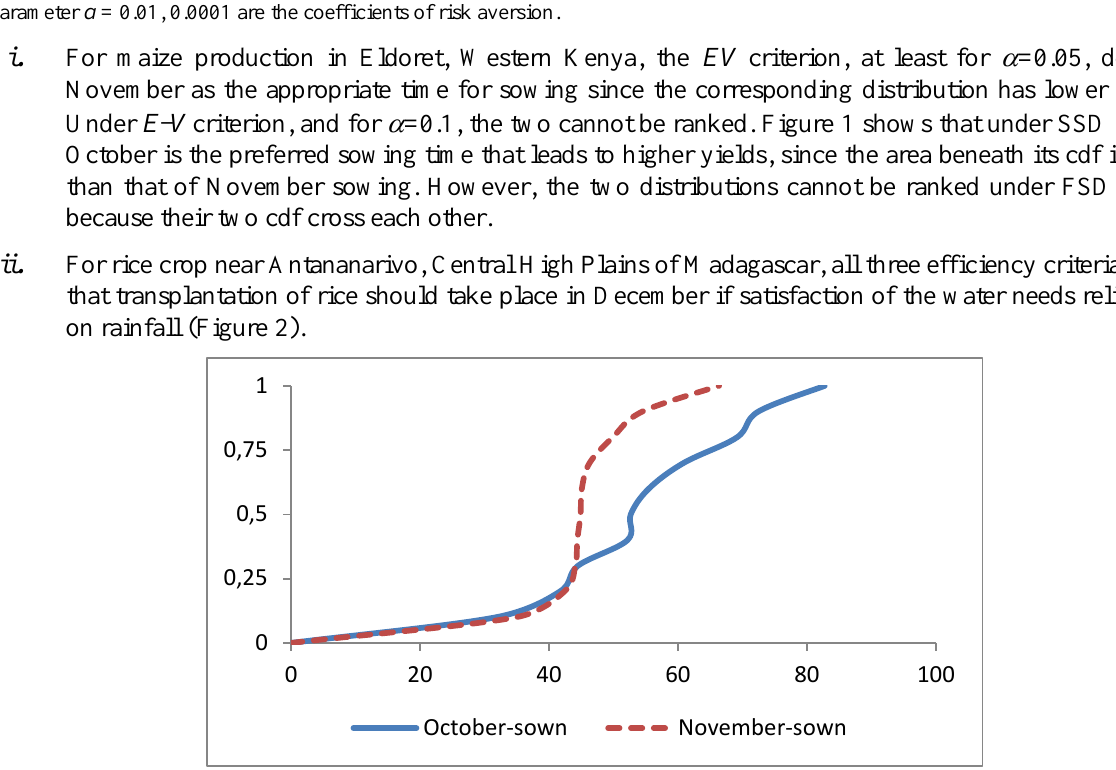
Figure 1 . Cumulative Distribution Functions of Forecasted Maize Yields (in % of Potential Yield) for Two Sowing